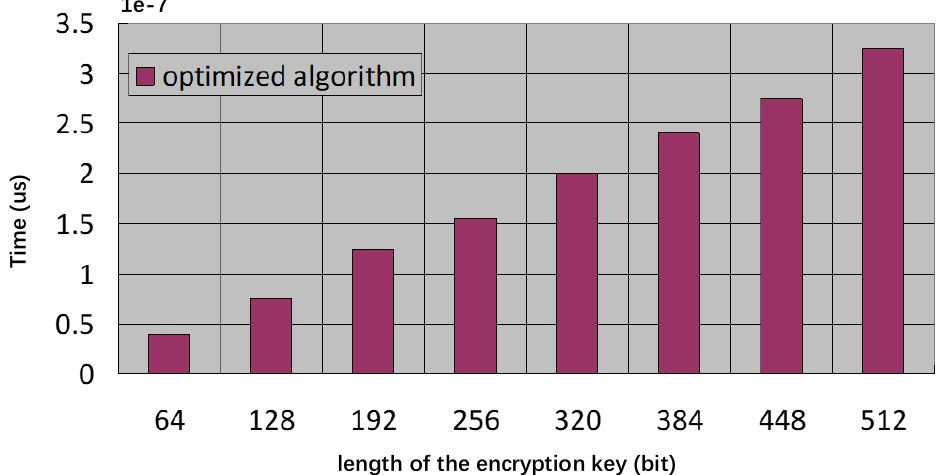
Figure 3. Encryption Time